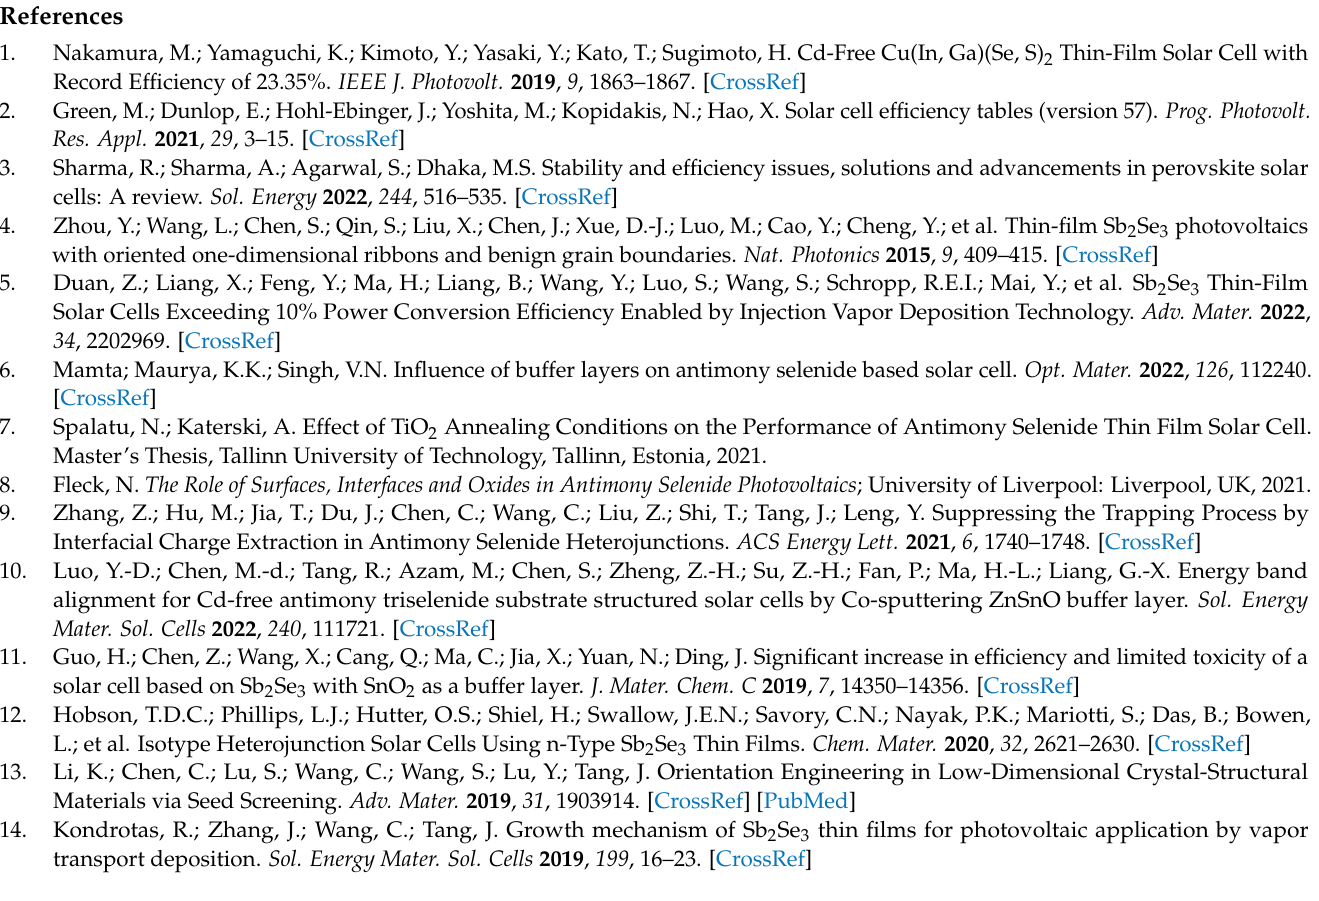
Figure S1 (schematic representation of VTD setup); Figure S2 (heating profiles during deposition process); Figure S3 (SEM and XRD of seed layers); Figure S4 (SEM cross-sectional images of seed layers); Figure S5 (SEM top-view and cross-sectional images of Sb 2 Se 3 solar cells); Table S1 (solar cell parameters); Table S2 (chemical composition of Sb 2 Se 3 absorber) and raw files of XRD, I-Vs and